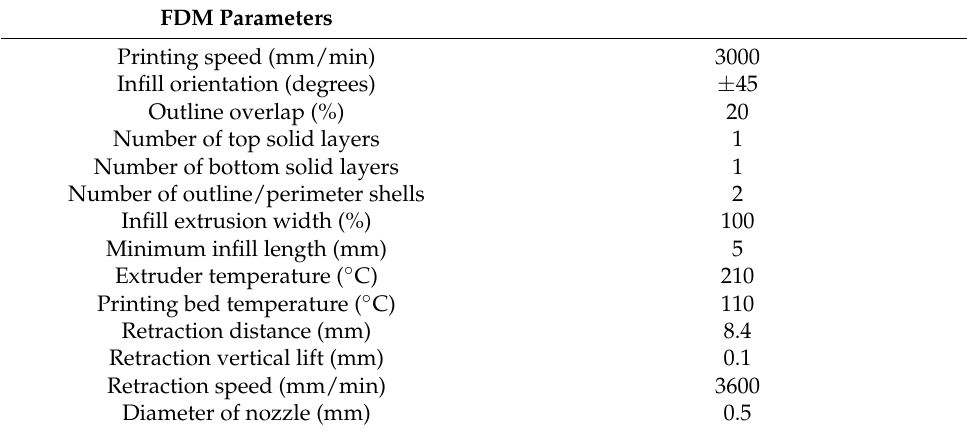
Table 1. FDM parameters applied in the study.